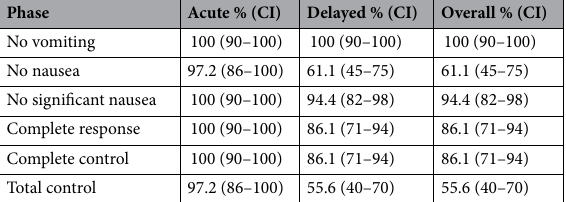
Table 4. Efficacy analysis in 36 patients. CI 95% confidence